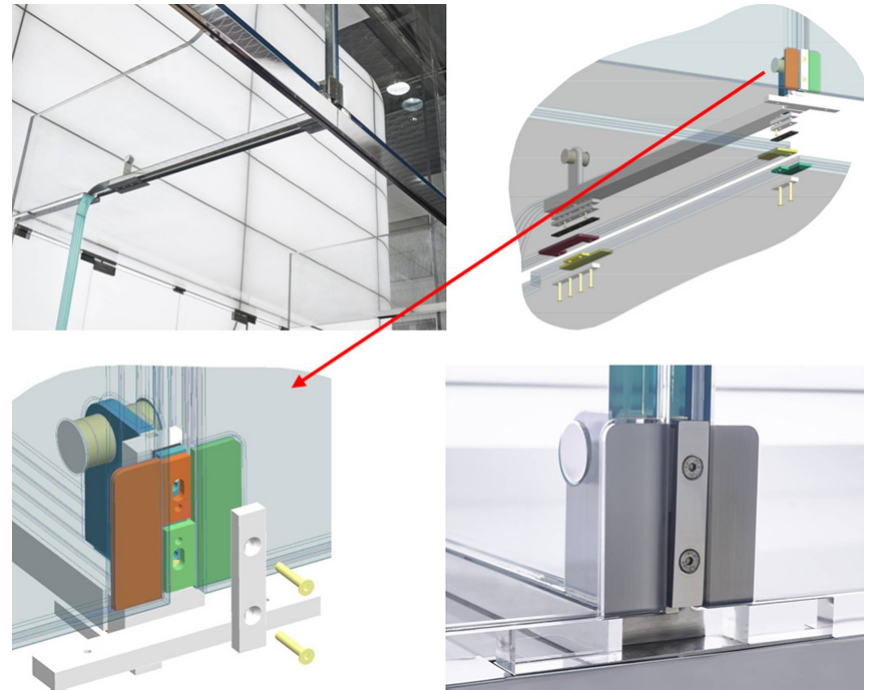
Fig. 11 Glass fin with Z-shape with laminated inserts to connect the roof and façade